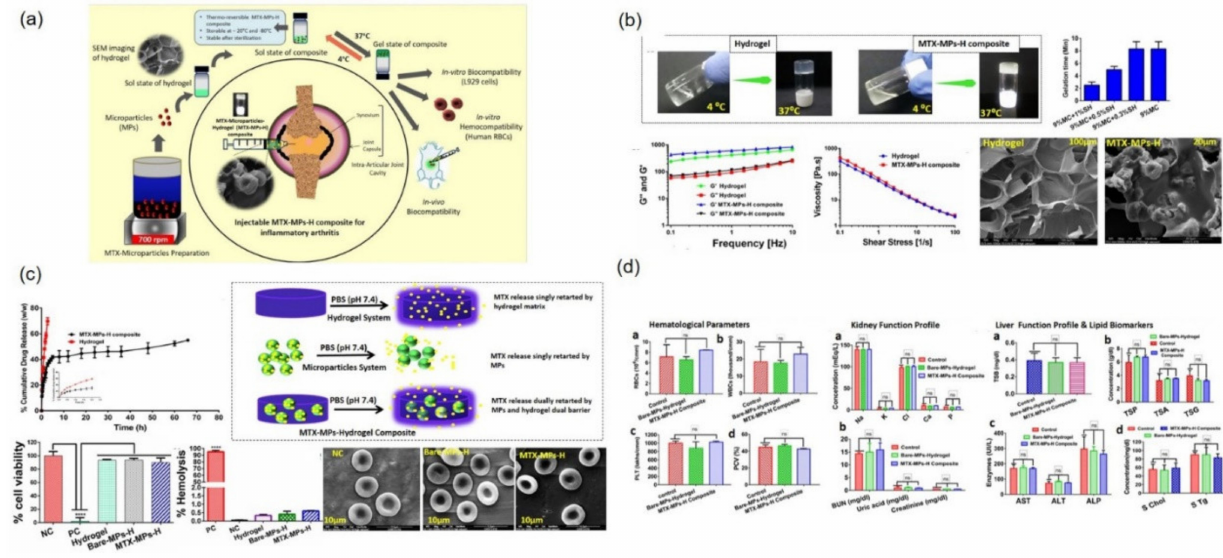
Figure 8. ( a ) Injectable methotrexate MP–hydrogel composite for anti-arthritic application. ( b ) T sol–gel , gelation time, viscoelastic properties, and morphology. ( c ) Hydrogel-mediated controlled MTX release. ( d ) In vivo biocompatibility studies. Adapted with permission from ref. [157], Copyright 2021